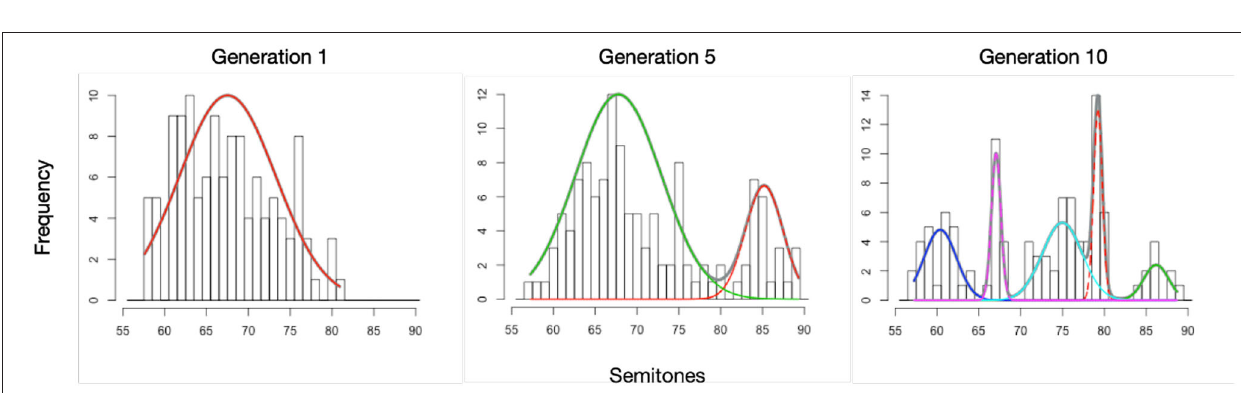
FIGURE 6 | Example results of the Gaussian Mixture models, used to measure discretization of the continuous pitch range into clusters of tone targets. These figures show the best fitting model for generation 1, 5, and 10 for one chain. More and clearer clusters are found in the less uniform later